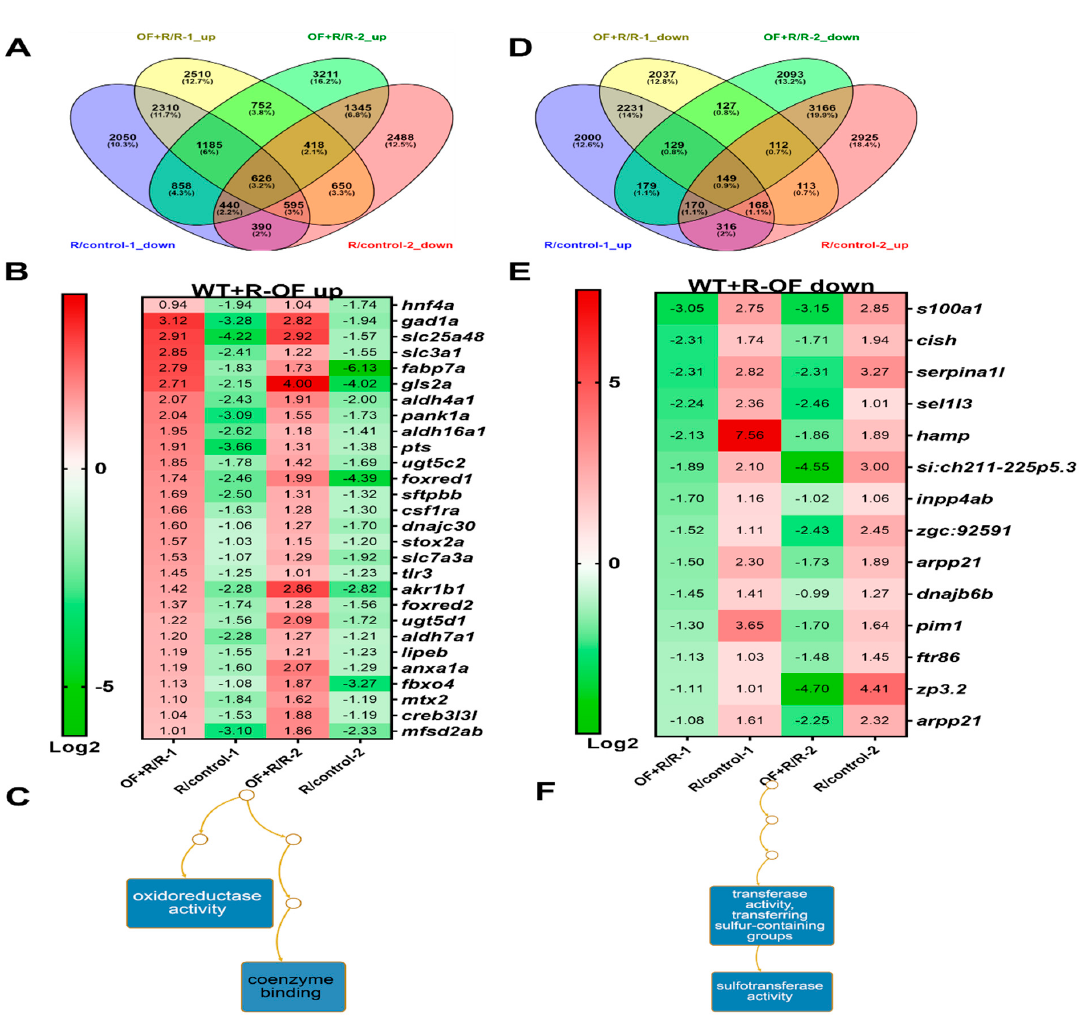
Figure 6. GeneTitan array analysis of the expression profile of wild-type zebrafish following di ff erent treatments. ( A ) Venn diagram of upregulation of genes in WT zebrafish irradiation and Oligo-Fucoidan pretreatment (OF + R) versus irradiation alone (R), overlapping with downregulated in irradiation (R) compare to no radiation (control). ( B ) The heatmap of genes that were upregulated in Oligo-Fucoidan pretreatment but downregulated by irradiation. First batch is 40 Gy (1), and second batch is 10 Gy (2). ( C ) Gene ontology analysis of Oligo-Fucoidan-induced genes in WT irradiation ( D ) Venn diagram of downregulation of genes in WT zebrafish irradiation and Oligo-Fucoidan pretreatment (OF + R) versus irradiation alone (R), overlapping with upregulated in irradiation (R) compared to no radiation (control). ( E ) The heatmap of genes that were downregulated in Oligo-Fucoidan pretreatment but upregulated by irradiation. First batch is 40 Gy (1), and second batch is 10 Gy (2). ( F ) Gene ontology analysis of Oligo-Fucoidan repressed genes in WT